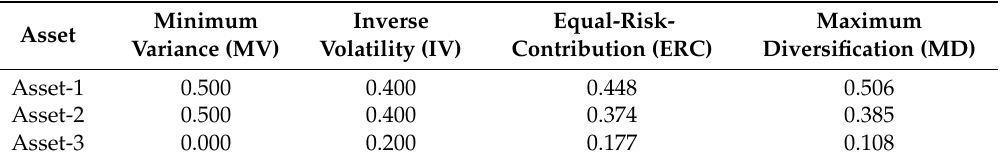
Table 2. True weights of the four risk-based